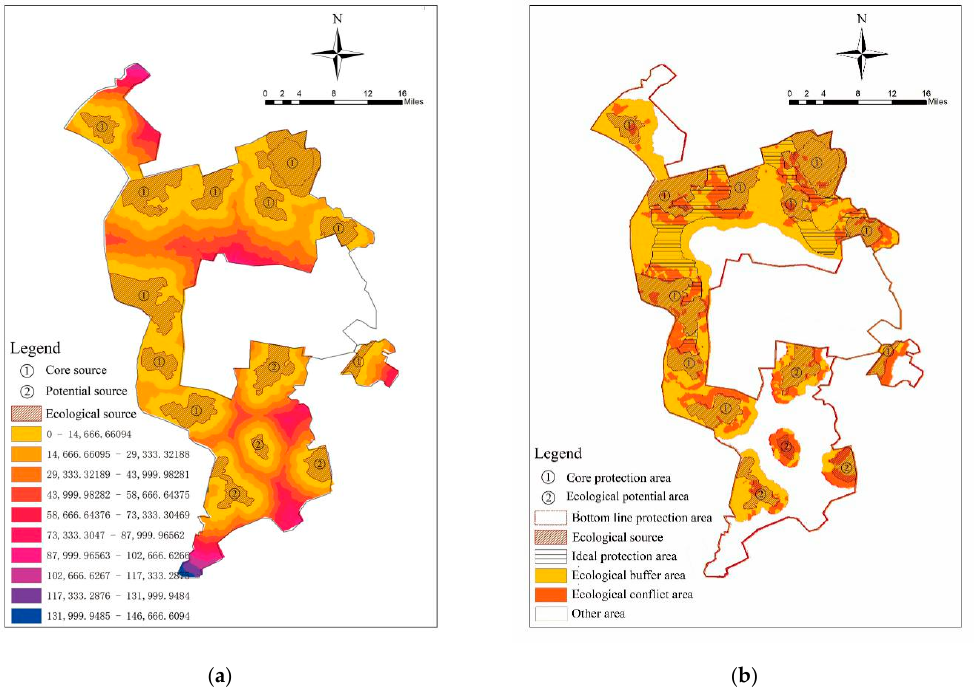
Figure 13. Protection area analysis: ( a ) resistance analysis; ( b ) protection area partition.